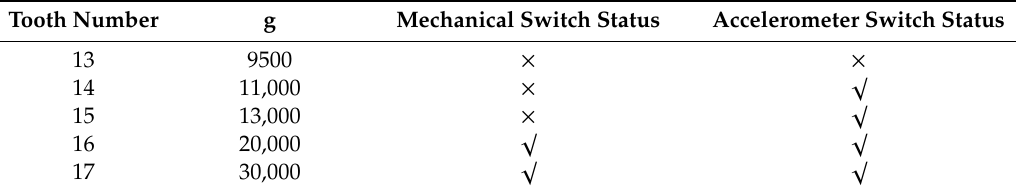
Table 1. Closure of overload switch with di ff erent teeth numbers.